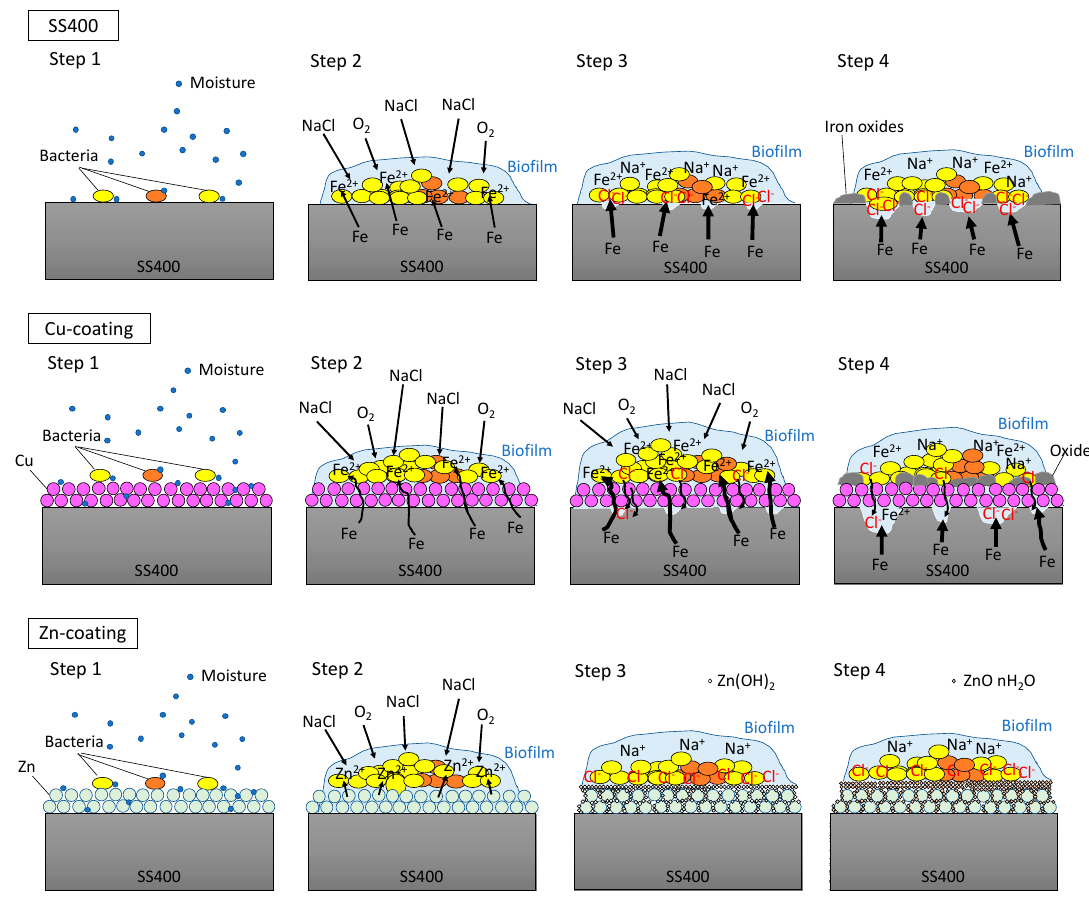
Figure 9. Predictive corrosion progression of the SS400 coupon, Zn-coated coupon, and Cu-coated coupon under outdoor conditions. Materials 2020 , 13 , 923